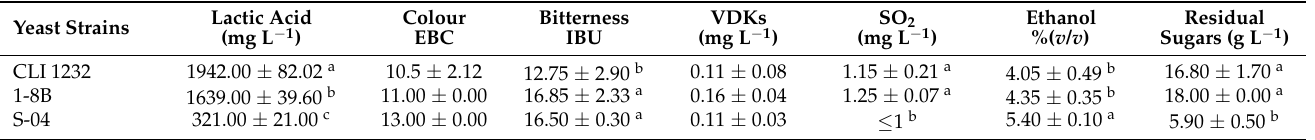
Table 3. Parameters analysed in the two selected sour beers fermented with the strains CLI 1232 and 1-8B and S-04 control strain in 1